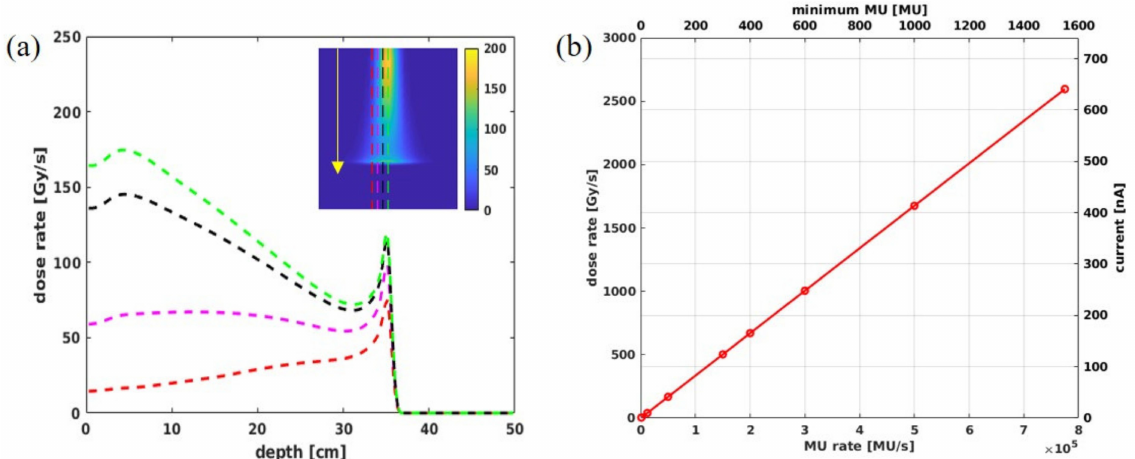
Figure 2. ( a ) The dose rate profile for a 240 MeV single spot with 100 MU at the central plane along depth direction (indicated by the arrow), ( b ) the theoretical calculation for nozzle current, minimum MU/spot, SPDR, and MU for proton beam under FLASH